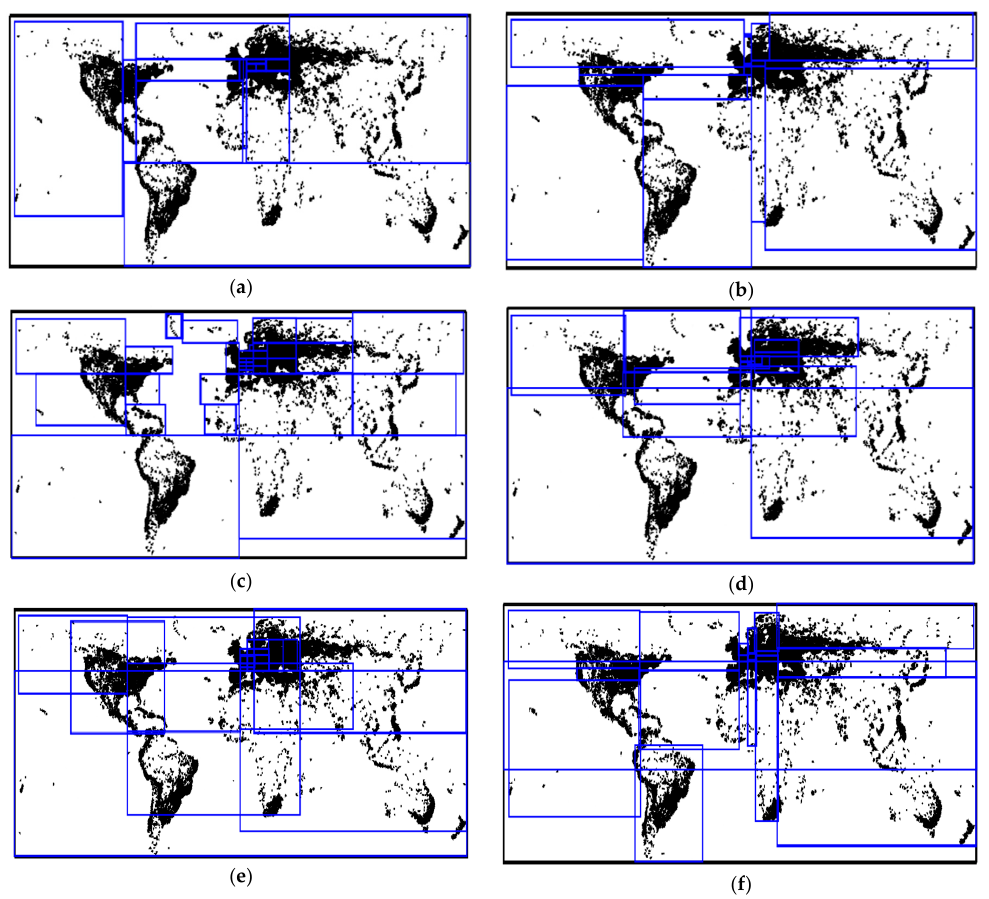
Figure 4. The Cities dataset indexed with different SpatialHadoop indexing techniques: ( a ) Cities indexed with the 2DPR-Tree; ( b ) Cities indexed with the KD-Tree; ( c ) Cities indexed with the Quadtree; ( d ) Cities indexed with the Hilbert-Curve; ( e ) Cities indexed with the Z-Curve; ( f ) Cities indexed with the STR and